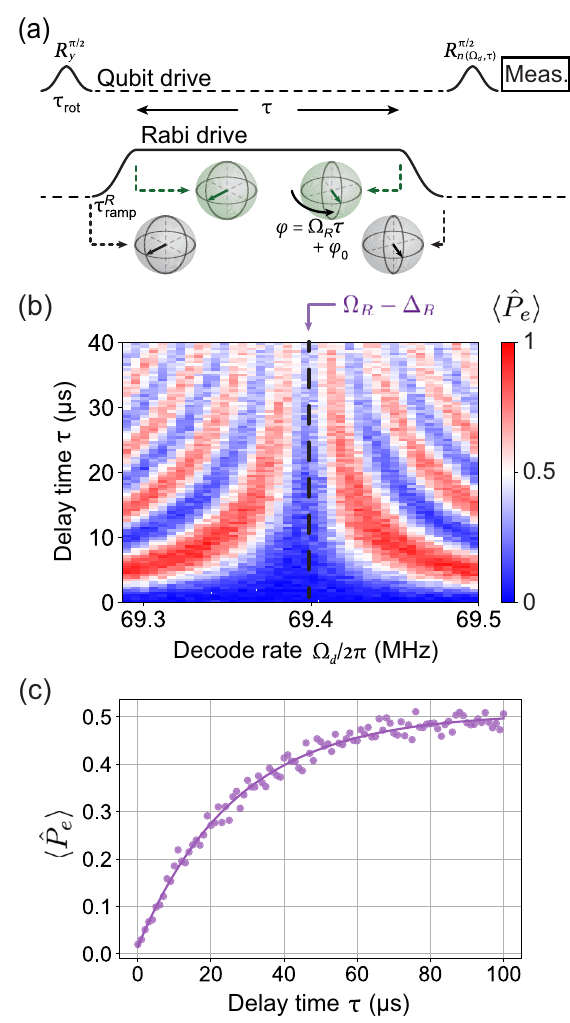
FIG. 8. Free evolution of the driven Rabi qubit. (a) A Ramsey- style pulse sequence is used to calibrate the decode rate. The final π = 2 rotation has a phase that depends on both the delay time τ and the programmed decode rate Ω . (b) The 2D plot reveals an d optimal decode rate which is inferred to be equal to the true Rabi − Δ frequency offset by the static detuning Ω . (c) The decode R R rate can then be fixed to the optimal value to extract a driven transverse relaxation time T 2 ρ ≈ 27 μ s via fitting to an exponen- tial decay function (solid